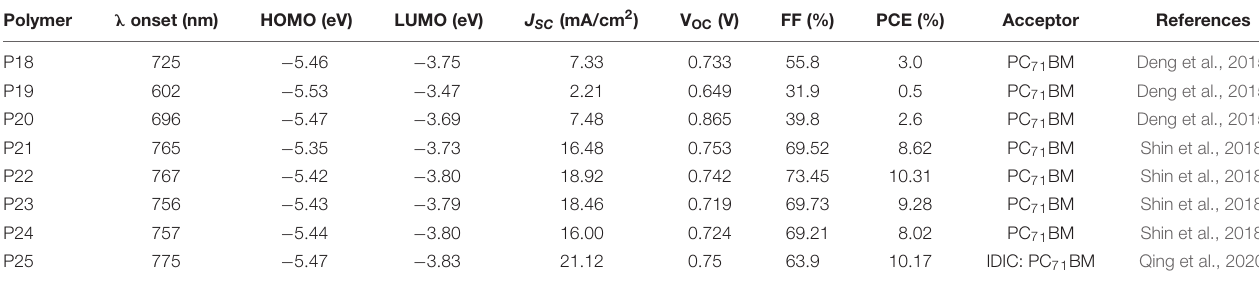
TABLE 2 | Summary of optical, electrochemical, and photovoltaic properties of polymers ( P18 – P25 ).